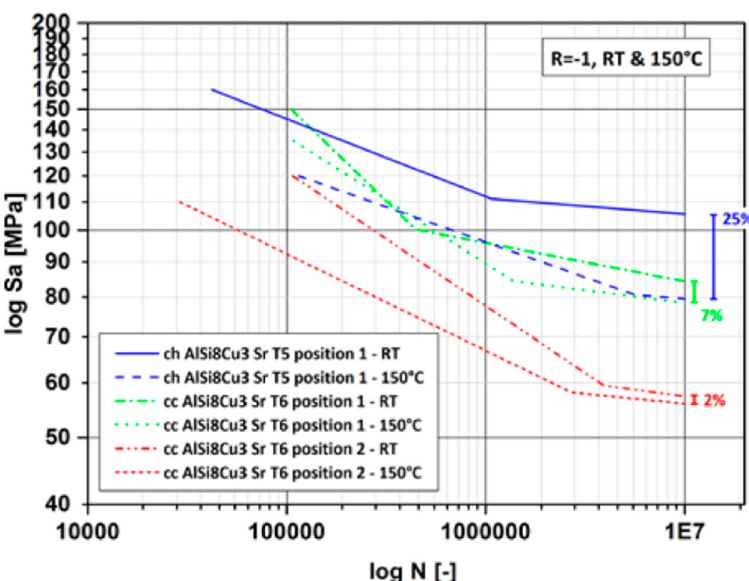
Figure 15. A summary of the stress/cycle S/N curves at room temperature and at 150 °C for a survival probability of 50% of AlSi8Cu3 (wt.%) alloy also listed with the fatigue strength reductions in percentage. It shows that at 150 °C the fatigue strength decreased by up to 25%, depending on location within the part due to porosity; Sa—stress amplitude [53].